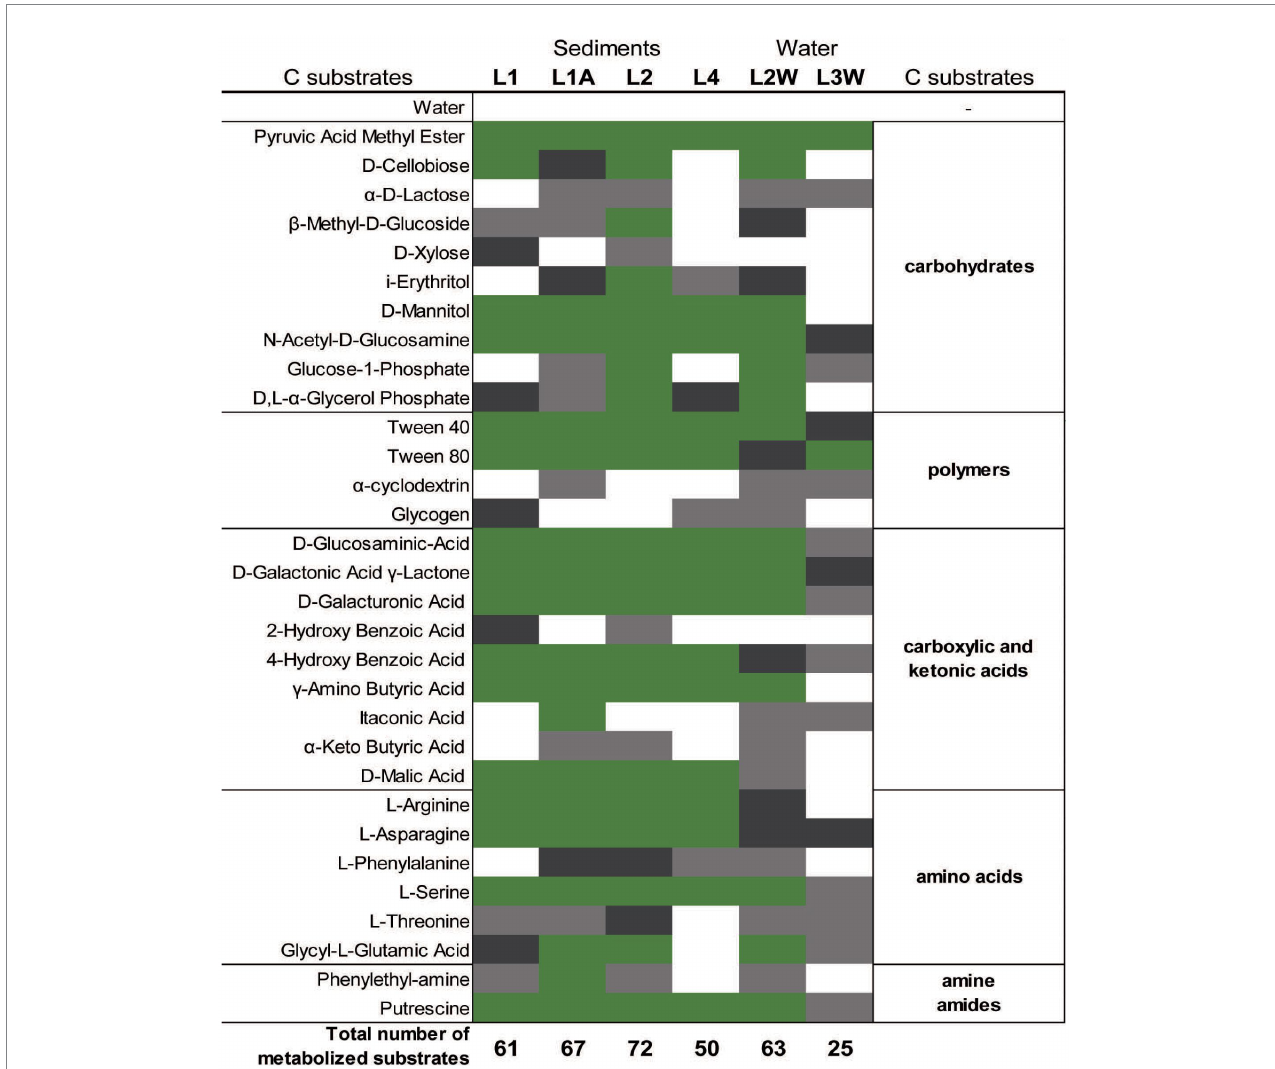
FIGURE 6 Color map of the metabolized different C-sources (substrates) among sediment and water samples collected. Substrate triplicate wells in which the color reaction occurred are marked with green (3/3 wells), dark grey (2/3 wells), light grey (1/3), and white